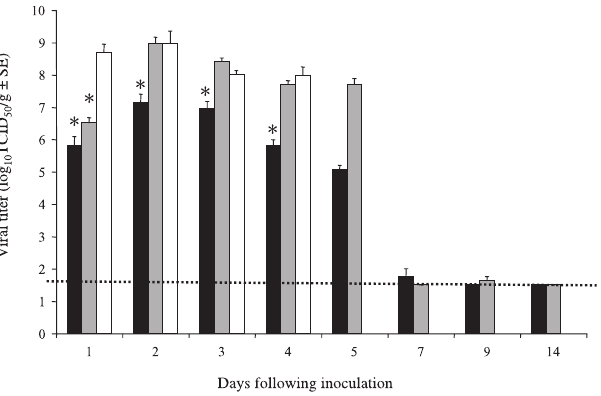
Figure 3. Virus Titers in Lungs of BALB/c Mice Inoculated with SARS-CoV or MA15 Virus Data represents a compilation of two experiments. In each experiment, groups of four mice were inoculated intranasally with 50 l L of SARS-CoV (Urbani) (10 5.0 TCID 50 /mouse, black bars) or MA15 virus at lethal (10 5.6 TCID 50 /mouse, white bars) or sub-lethal (10 3.6 TCID 50 /mouse, light gray bars) doses. Mice were sacrificed on indicated d.p.i. Mice receiving lethal doses of MA15 virus did not survive beyond day 4. Bars represent mean viral titers; error bars indicate standard error. Asterisks indicate significant differences ( p , 0.05) compared with titers in mice receiving lethal doses of MA15 virus. Dotted line indicates lower limit of detection (10 1.5 TCID 50 /g).